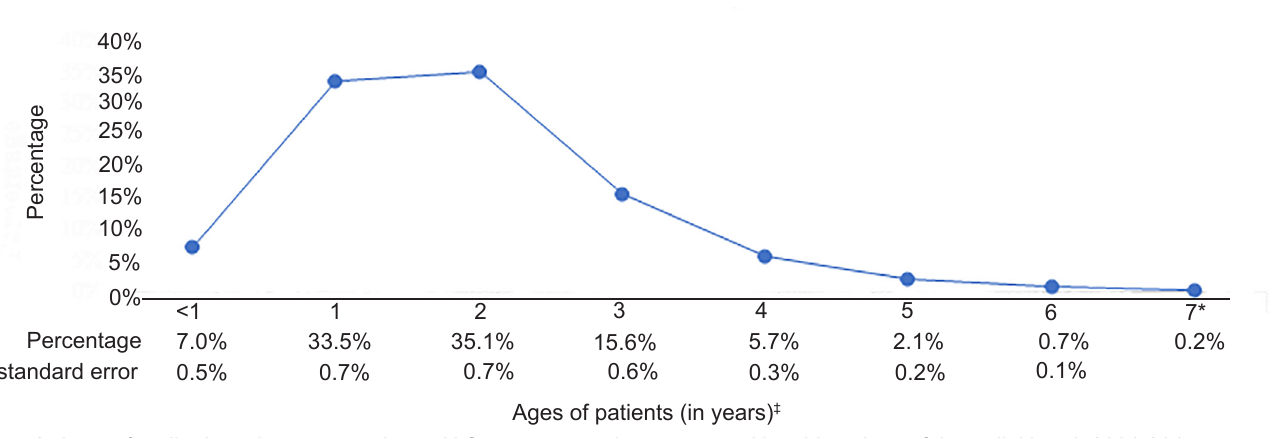
Figure 2. Ages of pediatric patients presenting to U.S. emergency departments with subluxations of the radial head, 2001-2017. *The estimate is considered to be potentially unstable due to the number of unweighted cases from the sample frame totaling <20, the weighted national estimate totaling <1200, or coefficient of variation >33%. Therefore, no standard errors or confidence intervals are provided; the unstable percentage estimate is provided for reference purposes only. Variable results with sample frame totals <20 cases or percentages <0.1% were omitted from this table, resulting in percentage totals not necessarily summing to